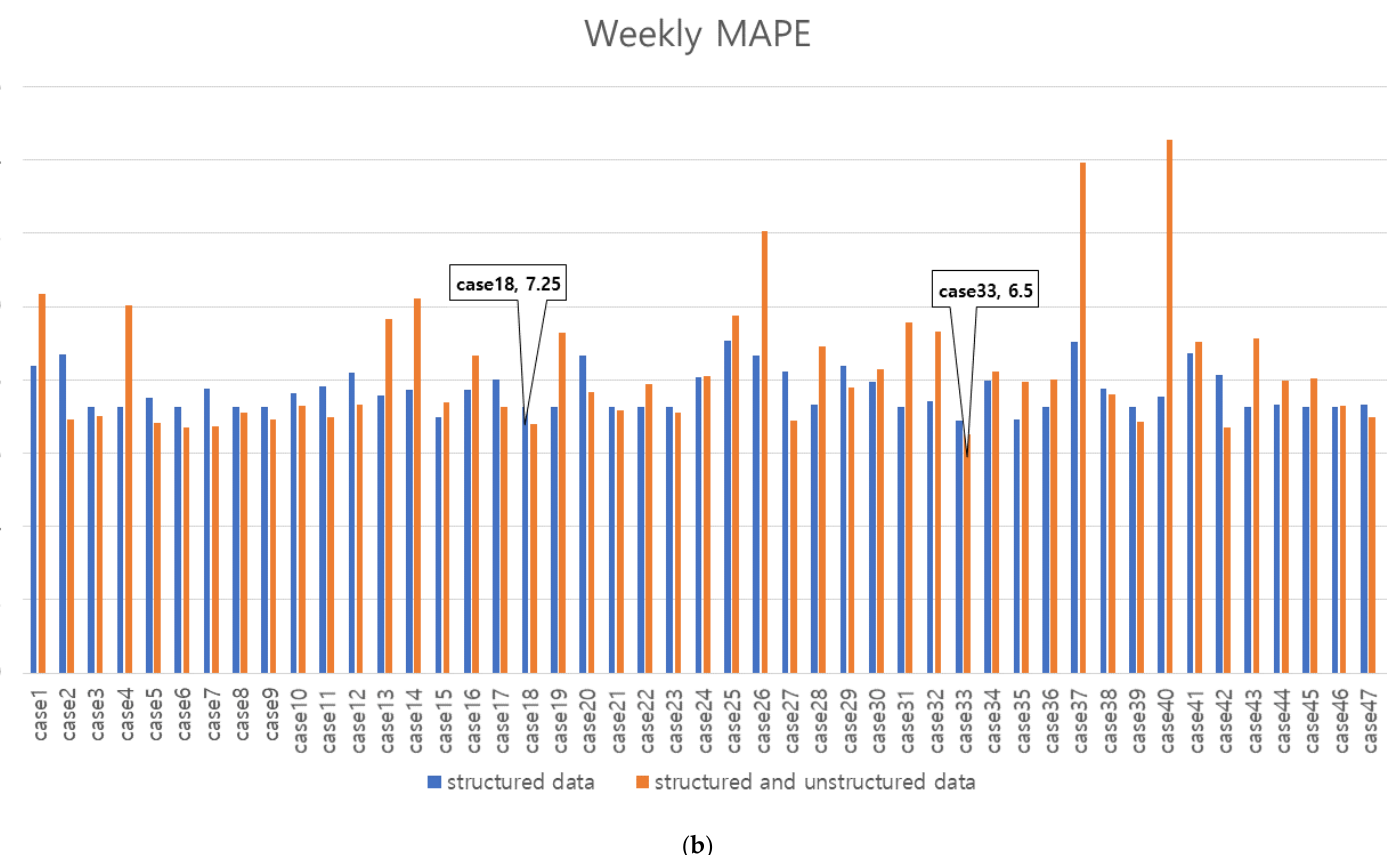
Figure 6. Comparison of the forecasting results by structured data with the forecasting result by structured and unstructured data in daily basis ( a ) and weekly basis ( b ).